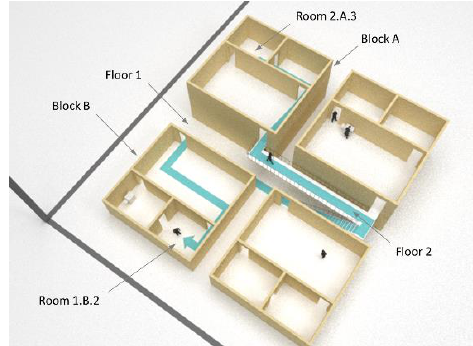
Figure 8. Expansion vs Contraction of an address. As the agent moves between the sub-spaces to reach Room 1.B.2 his/her address inflates and then